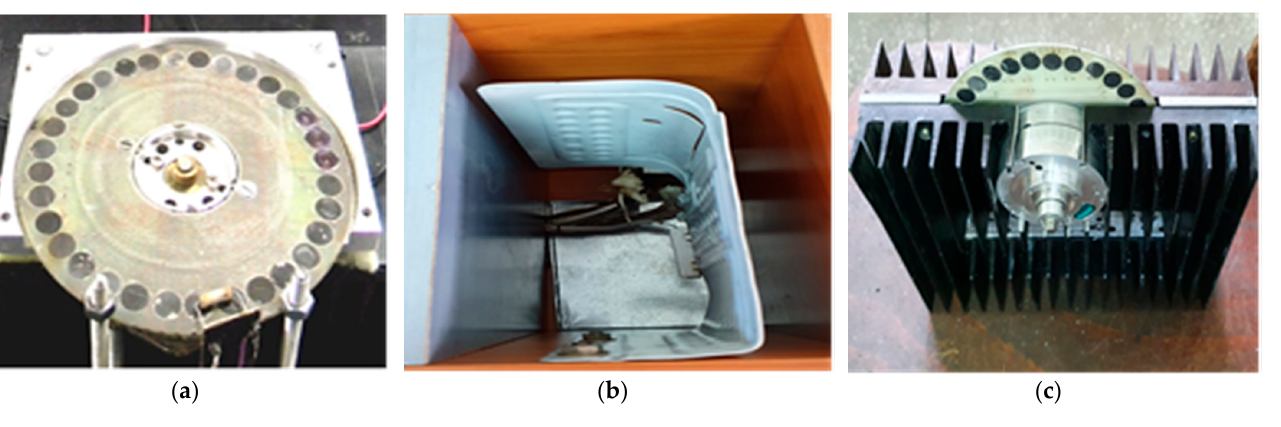
Figure 6. Experimental gadolinium motor stand—variant 1: ( a )—rotor with gadolinium pills and heating resistors; ( b )—cooling system; ( c )—general view [1,25].